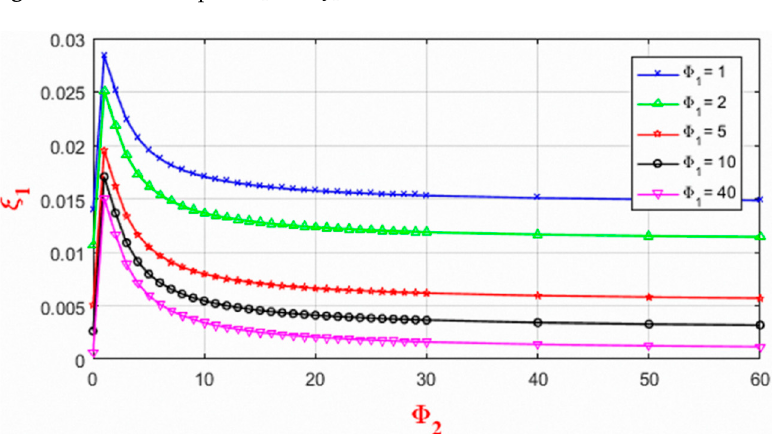
Figure 4. Relationship of Φ 1 and ξ 1.